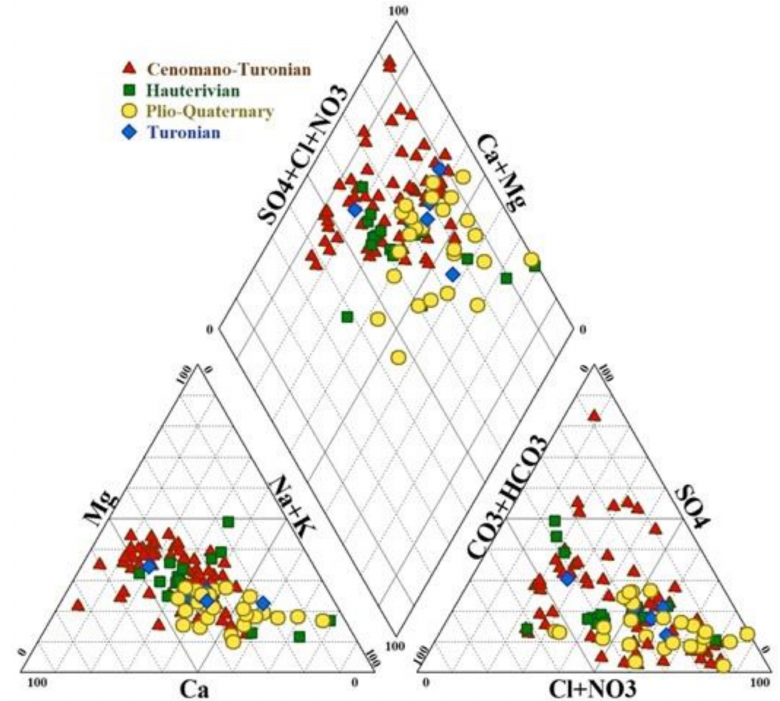
Figure 13. Piper diagram of the analyzed samples (campaign of